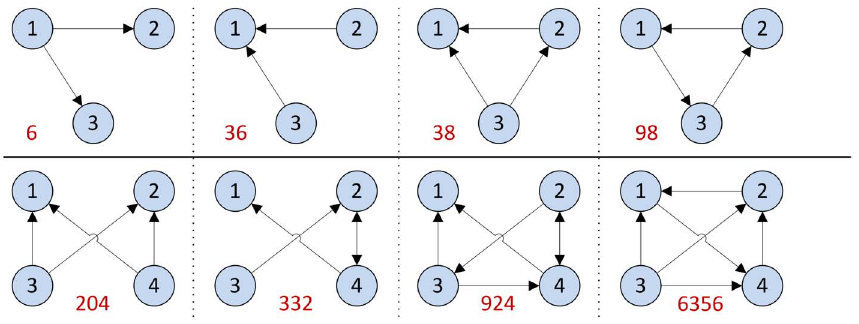
Figure 3. Network motifs with 3 or 4 nodes. Analysis results of the respective motif can be found in Table 5.